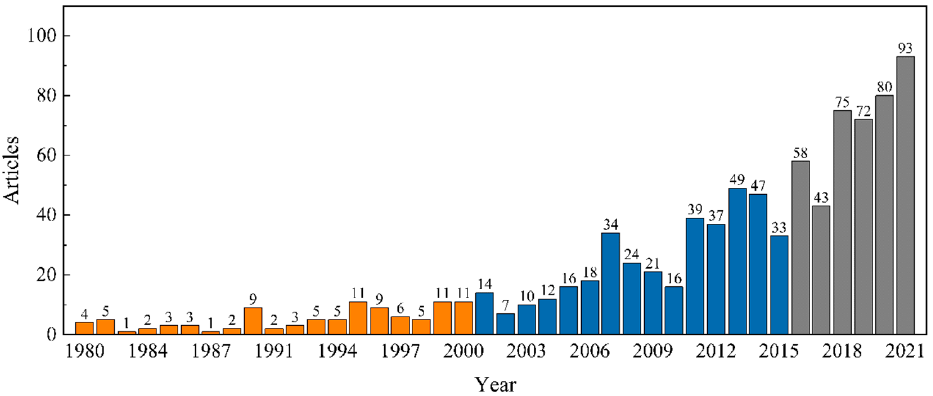
Figure 2. Number of articles on farmland abandonment published from 1980 to 2021 (Note: The different colors in the figure represent the three stages of the number of articles published).